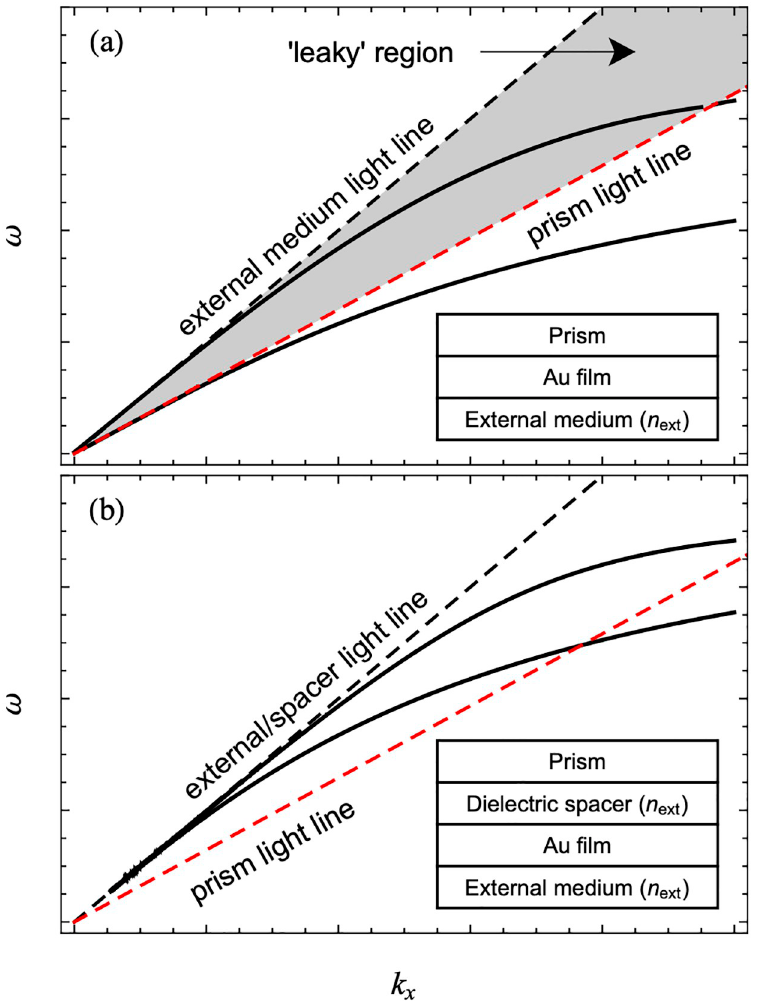
Fig 2. Dispersion relationships for a single gold film. a) the standard Kretschmann configuration; b) the Kretschmann configuration with the addition of a dielectric spacer layer. Shown are the SPP modes (black) and the relevant light lines. The area shaded grey is the region in which leaky modes are